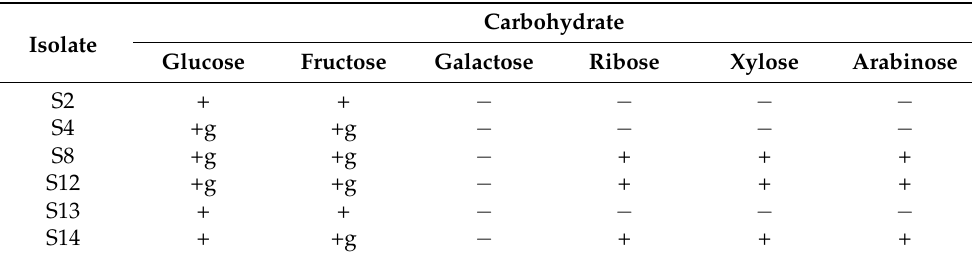
Table 4. Fermentation pattern of hexoses (glucose, fructose or galactose) or pentoses (ribose, xylose or arabinose) of isolates S2, S4, S8, S12, S13 and S14 obtained from the intestinal content of rainbow trout when cultured in MRS broth plus phenol red.